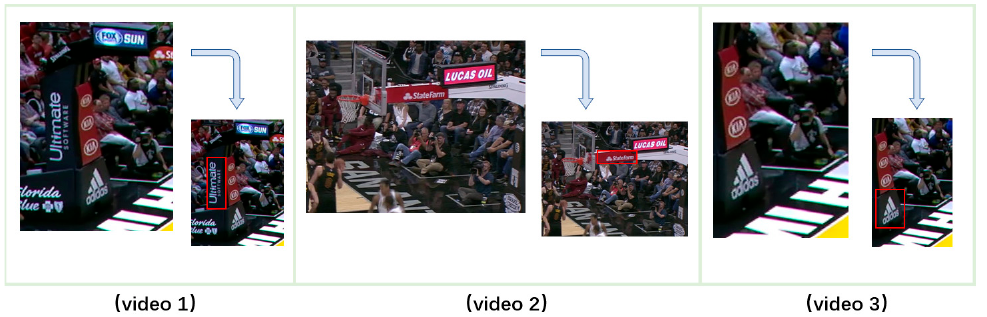
Figure 7. Three di ff erent targets in the BSA dataset. Figure 7. Three different targets in the BSA dataset.